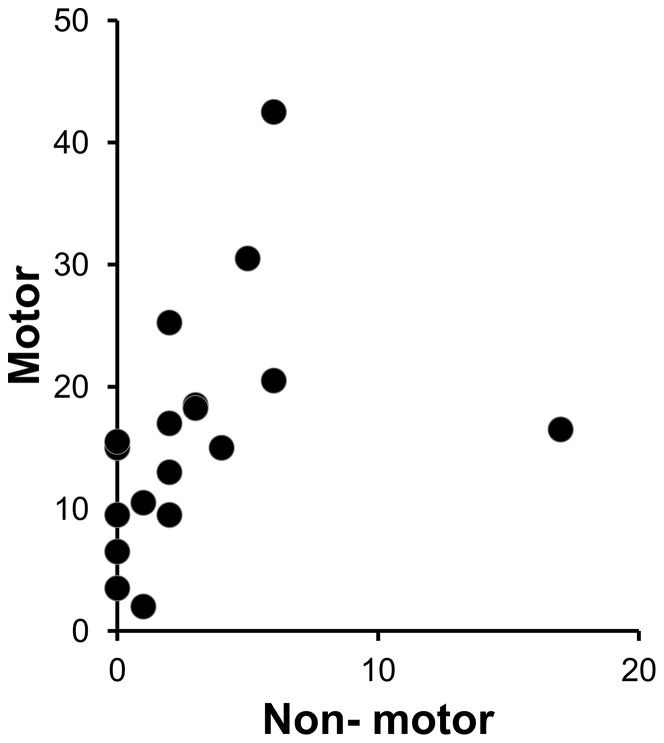
Motor scores correlate with non-motor scores of SC patients evaluated by USCRS.USCRS rates motor and non-motor symptoms on a 0–4 severity scale (0 = none to 4 =  severe). In our patients the sum of motor symptom (items 7–21) were closely correlated (r = 0.70, P = 0.0011) with the sum of non-motor items (1–6).